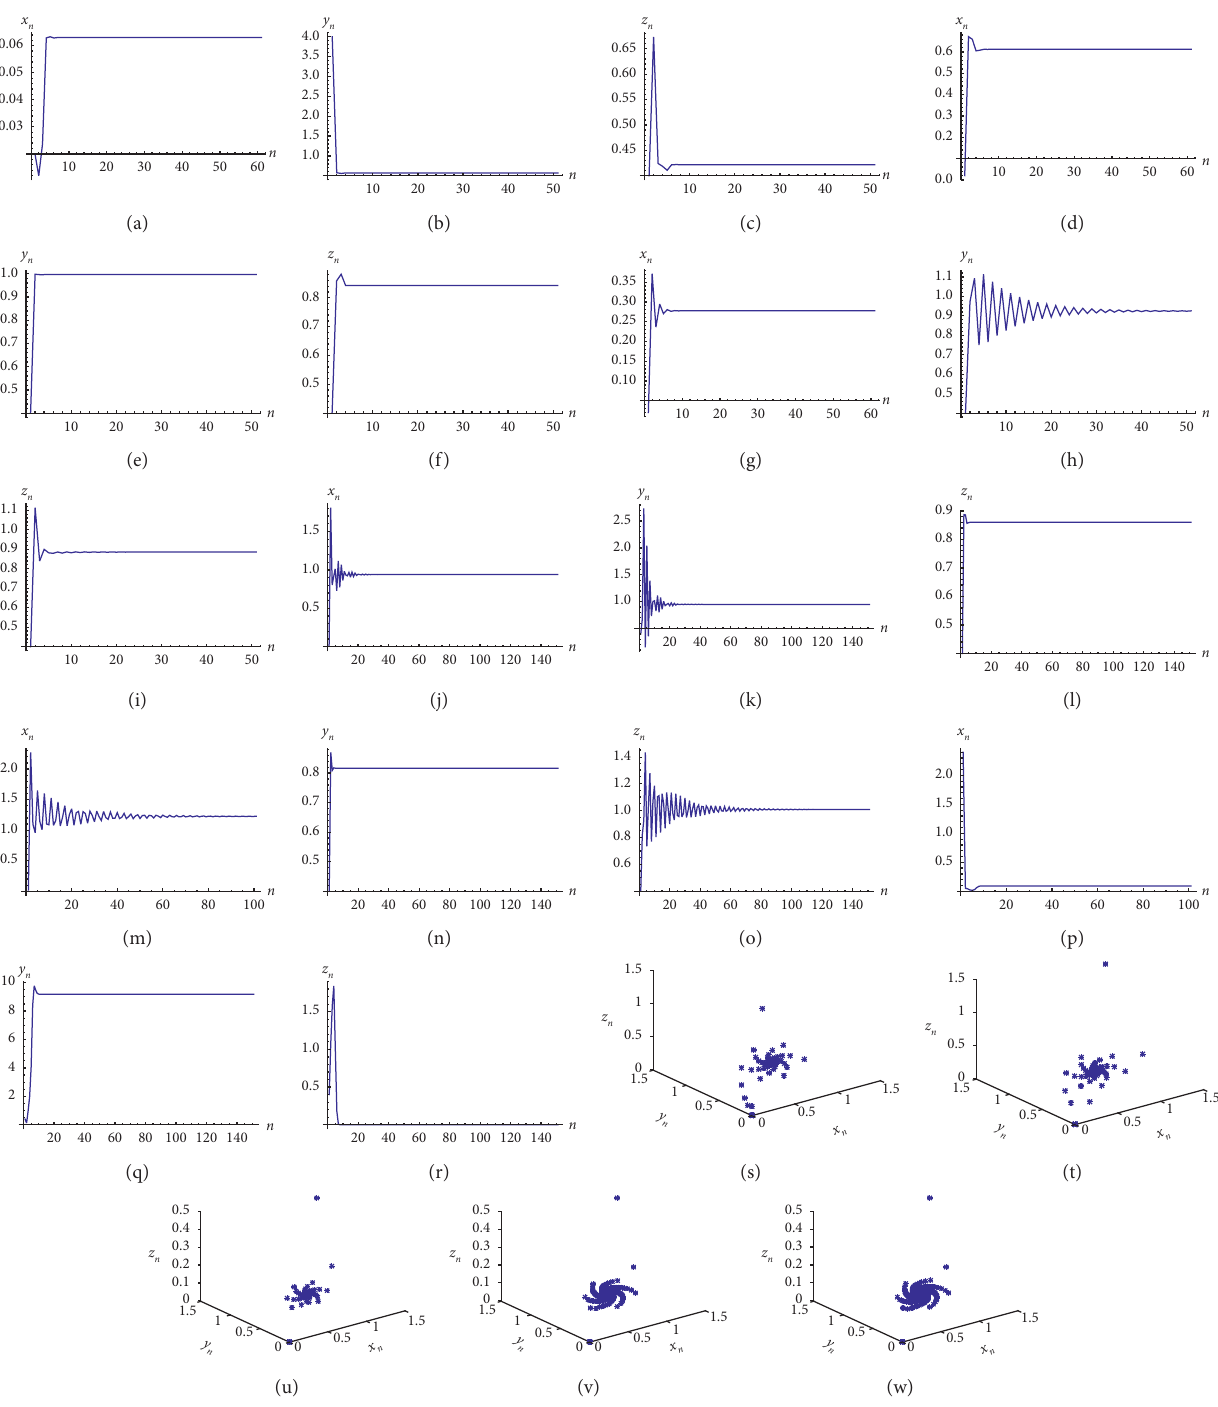
,y ,z ( s � − 1 , 0 ) , respectively, being 0 . 7 , 2 . 4 , 0 . 9 , 0 . 4 , 1 . 9 , and 0 . s s s